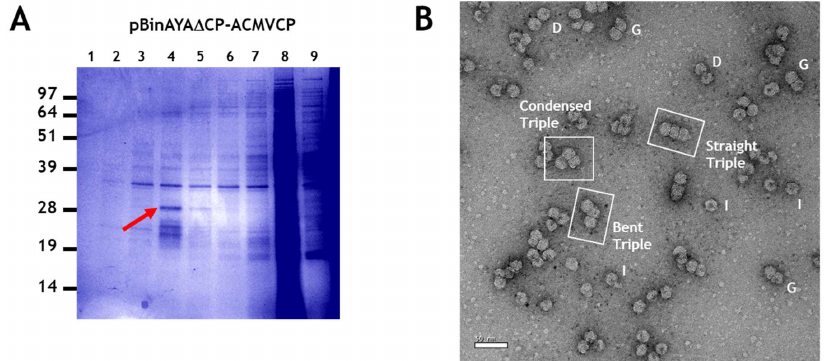
Figure 6. ( A ), Caesium sulphate gradient separation of particles isolated from pBinAYA ∆ CP-ACMVCP infiltration. Red arrow indicates fraction containing ACMV coat protein. ( B ), Transmission electron microscopy of particles present in the peak fraction, (red arrow) following the infiltration of plant leaves with pBinAYA ∆ CP-ACMVCP. Isometric (I), geminate (G) and (D) double particles are indicated. The 3 morphological forms of the triple particles—straight, bent and condensed—are indicated. Bar = 50 nm.